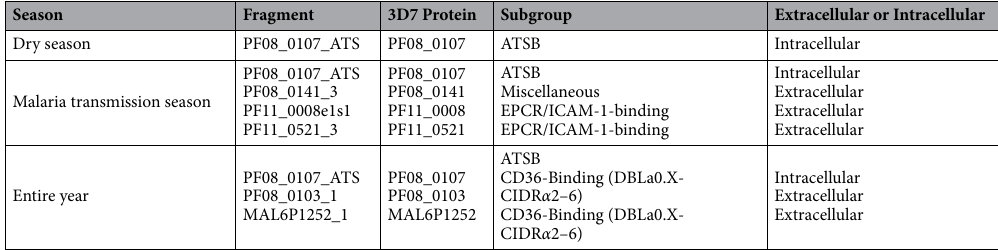
Table 2. Subsets of PfEMP1 fragments serorecognized by all Malian adults across the dry and malaria transmission